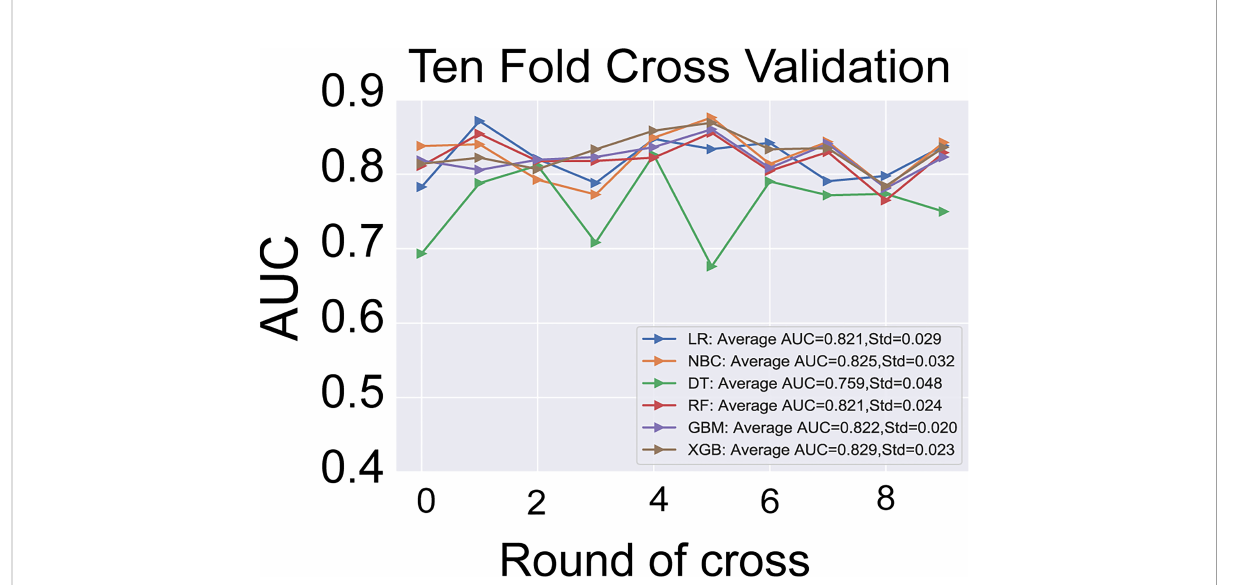
FIGURE 2 The results of 10-fold cross-validation in the six models of LR, NBC, DT, RF, GBM, and XGBoost. The average AUC of XGBoost model is the highest one. LR, Logistic Regression; NBC, Naive Bayes Classi fi er; DT, Decision Tree; RF, Random Forest; GBM, Gradient Boosting Machine; XGBoost, Extreme Gradient Boosting; AUC, area under the receiver operating characteristic curve.